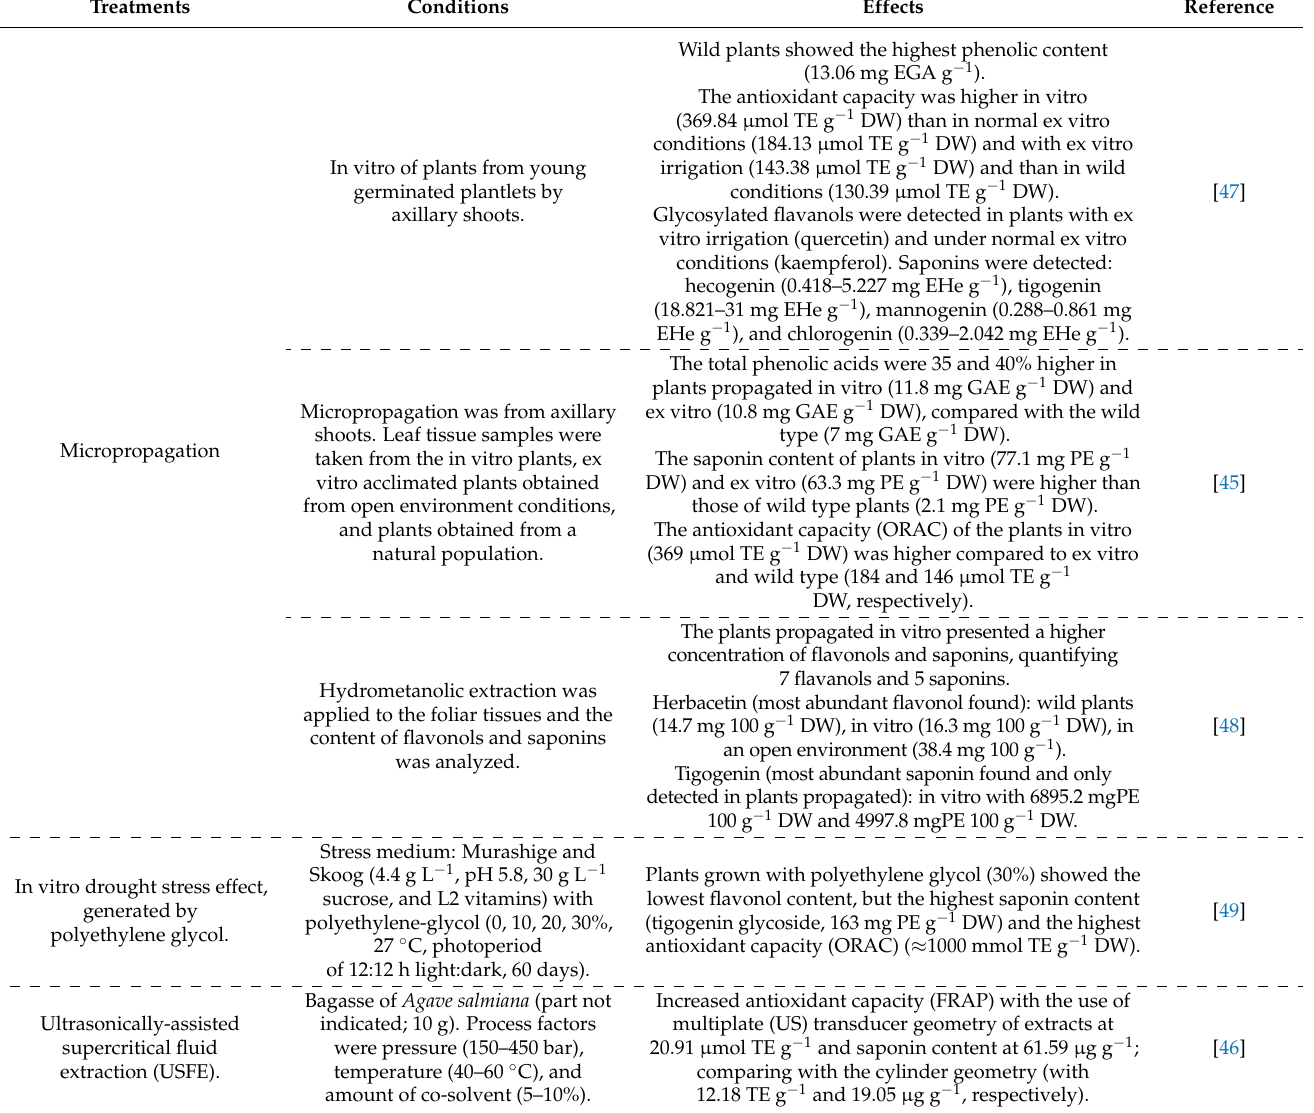
Table 3. Modification of composition and/or bioactivity determined in Agave salmiana by different